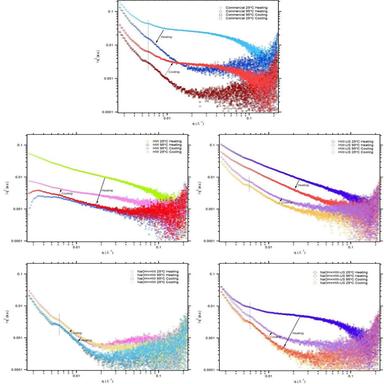
Kratky plots from the SAXS patterns collected at 25 °C and 95 °C during the heating and cooling ramps. (A) Commercial; (B) HW; (C) HW-US; (D) NaOH+HW and (E) NaOH+HW-US.